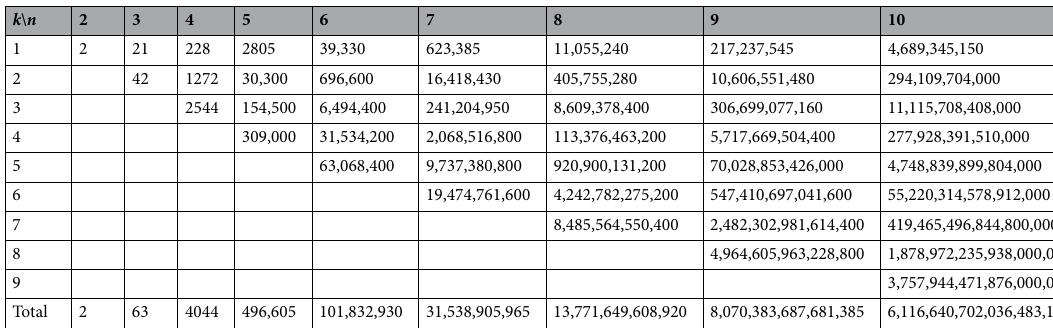
k < n and 2 n 10 . The last row contains ≤ ≤ ≤